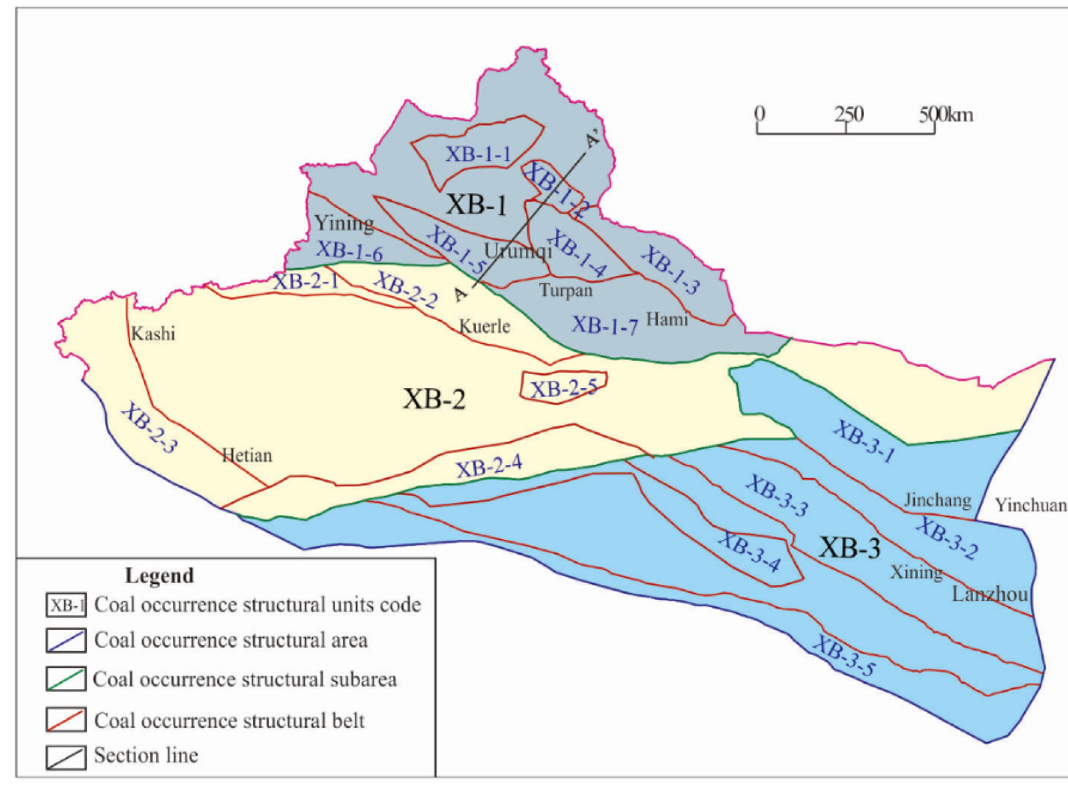
Fig. 11 Division of the coal occurrence structural units in the Northwest China coal occurrence structural